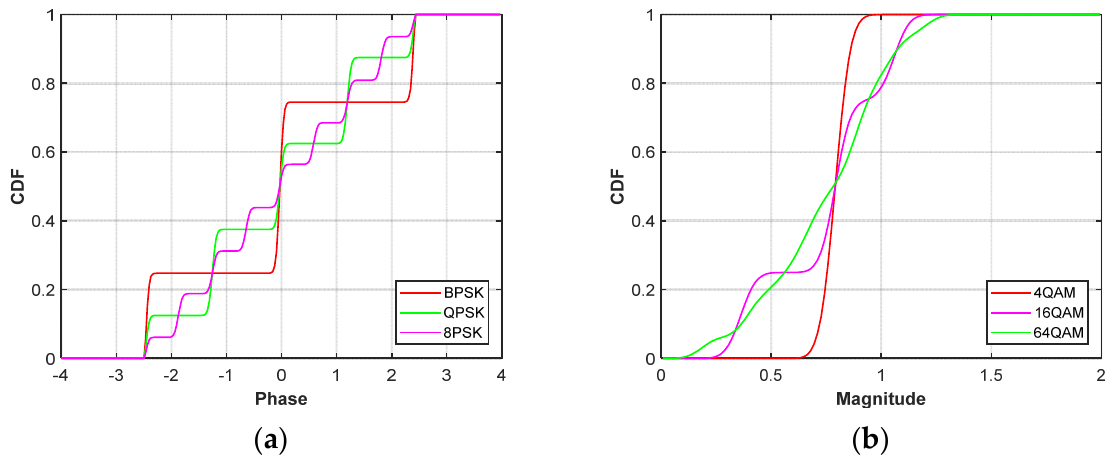
Figure 3. The ECDFs of decision statistics at SNR = 20 dB, N = 128. ( a ) MPSK. ( b ) MQAM.